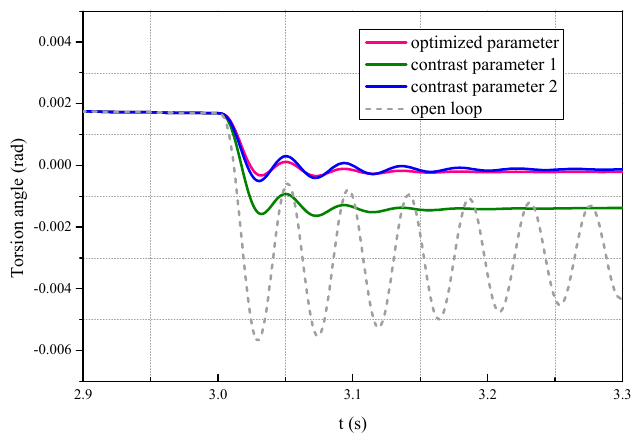
Figure 11. Drive shaft speed oscillations.